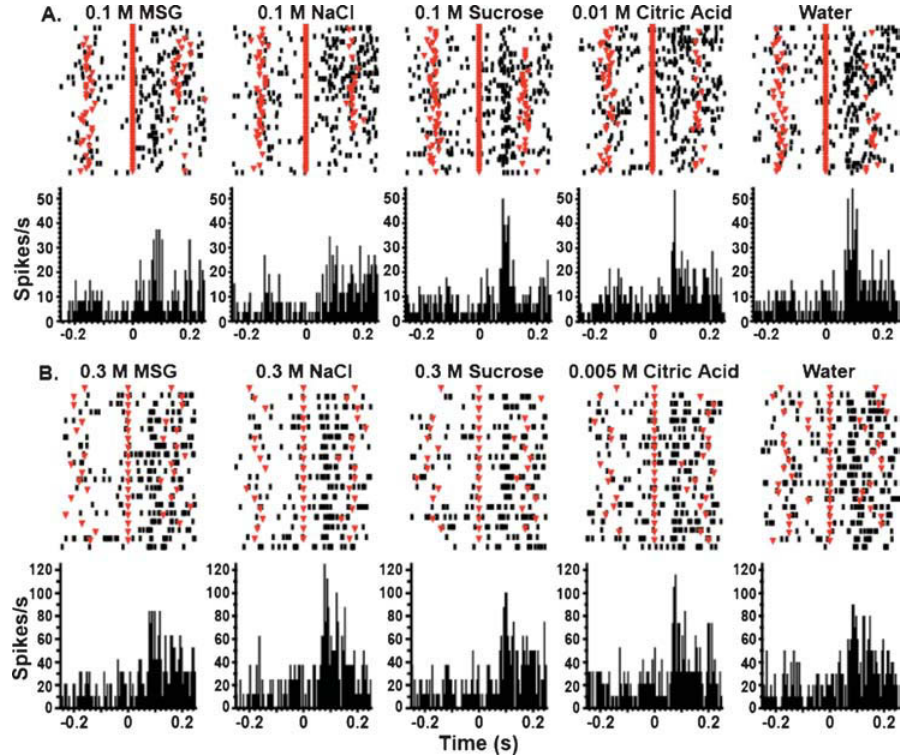
Figure 1. GC neurons respond rapidly to tastants under the FR5 and random FR5 schedules. (A) These peristimulus time histograms (PSTHs) represent the activity of a single neuron tested on the FR5 schedule. Each panel depicts the neuron’s response to one concentration of a particular tastant. The raster plots are depicted at the top of each panel, and the top row represents the first stimulus trial. The bottom portion of each panel depicts the corresponding PSTH. Zero on the abscissa denotes the time of tastant delivery (red triangles aligned at 0ms on the raster plots), and the ordinate is given in terms of spikes per second. The unreinforced lick times are depicted as inverted triangles overlaid on the raster plots at approximately ± 150ms. The bin size for the PSTHs is 5ms. The activity of this neuron indicates that it is broadly tuned and responds to all of the tastants. Note that the pattern of its responses is different for different tastants. (B) These PSTHs depict the activity of a single neuron tested on the random FR5 schedule. Conventions are the same as in A. As with the neuron depicted above, this neuron is also broadly tuned and responds to all proffered tastants. NaCl and citric acid evoked the greatest responses from this